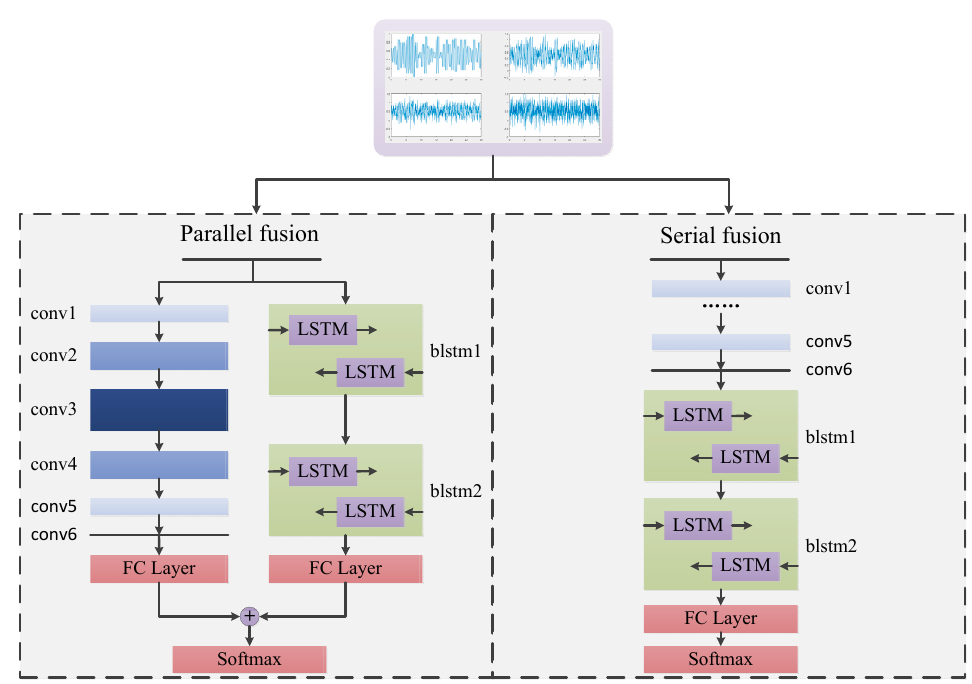
Figure 3. Fusion model structure of heterogeneous deep model fusion (HDMF) in parallel and series modes. We note that two HDMF models are used separately to solve the AMC problem.